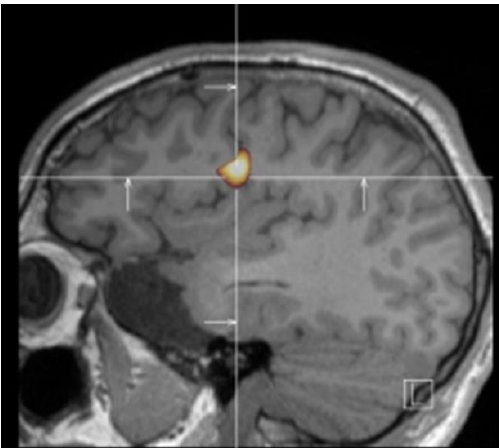
Figure 1. Cerebral MRI (sagittal view) and ictal/interictal technetium-99m HMPAO (99mTc-HMPAO) SPECT subtraction using BRASS analysis program in a patient with ecstatic epilepsy. It shows an increased blood flow maximal at the junction of the right dorsal mid-insula and central operculum. Adapted from a Figure published in Cortex 49 (2013), F. Picard, State of belief, subjective certainty, and bliss as a product of cortical dysfunction, page 2495, Reproduced with permission from Elsevier.